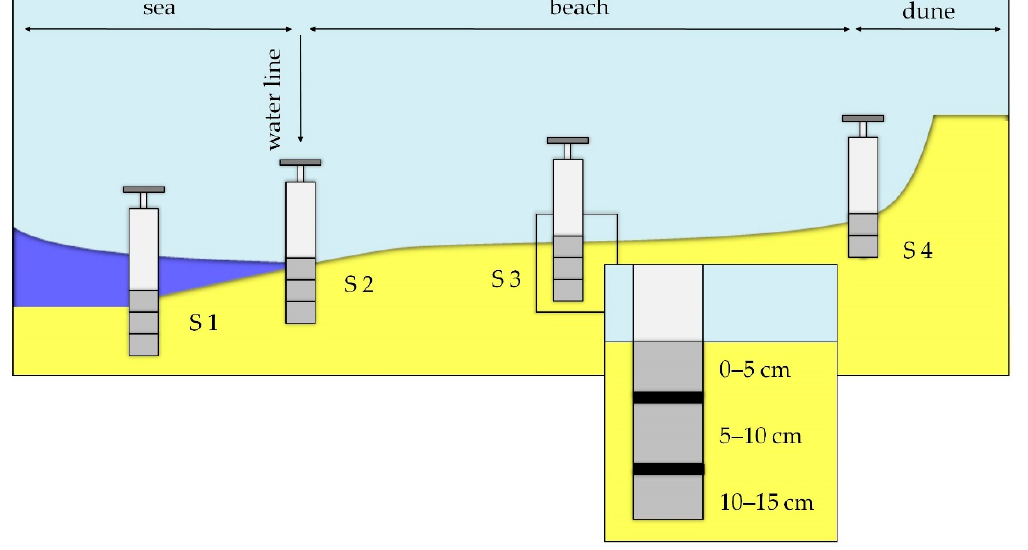
Figure 2. Location of sampling sites and presentation of the horizontal profile of one of the beaches.